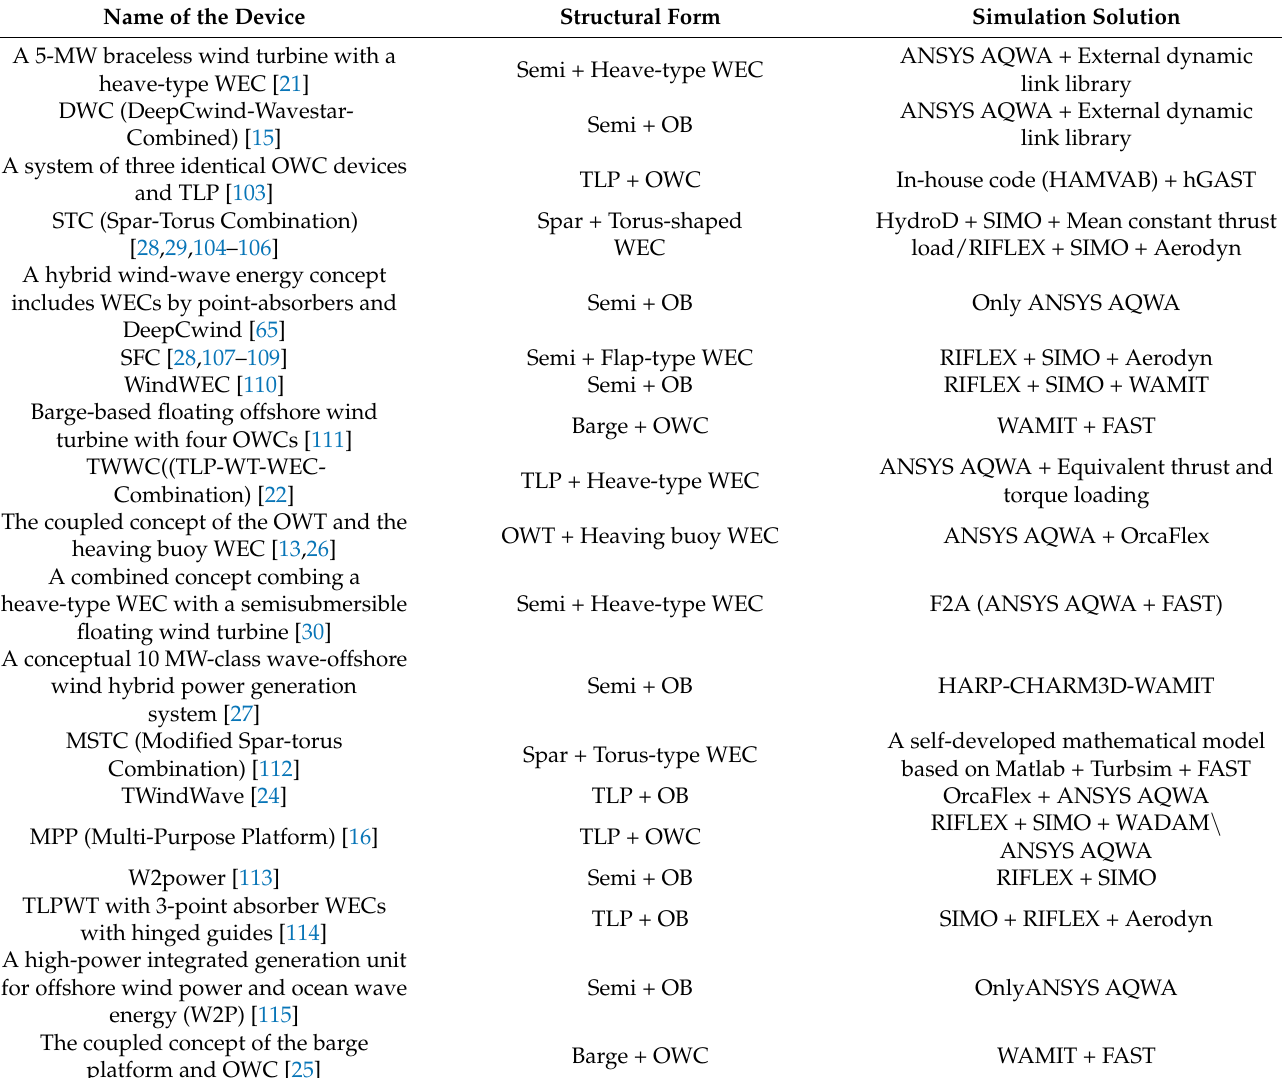
Figure 9. Schematic diagram of the fully-coupled numerical simulation flow of CWWHDs. Table 3. Combined simulation methods for CWWHDs.